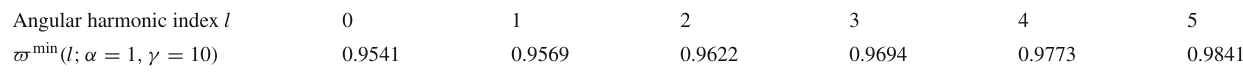
Table 3 Resonant oscillation frequencies of the composed stationary compact-reflecting-star–linearized-massive-scalar-field configurations with α = 1 and γ = 10. We present the smallest resonant oscillation frequency (cid:16) min ( l ) which characterizes the stationary bound-state star– field configurations for various values of the dimensionless harmonic